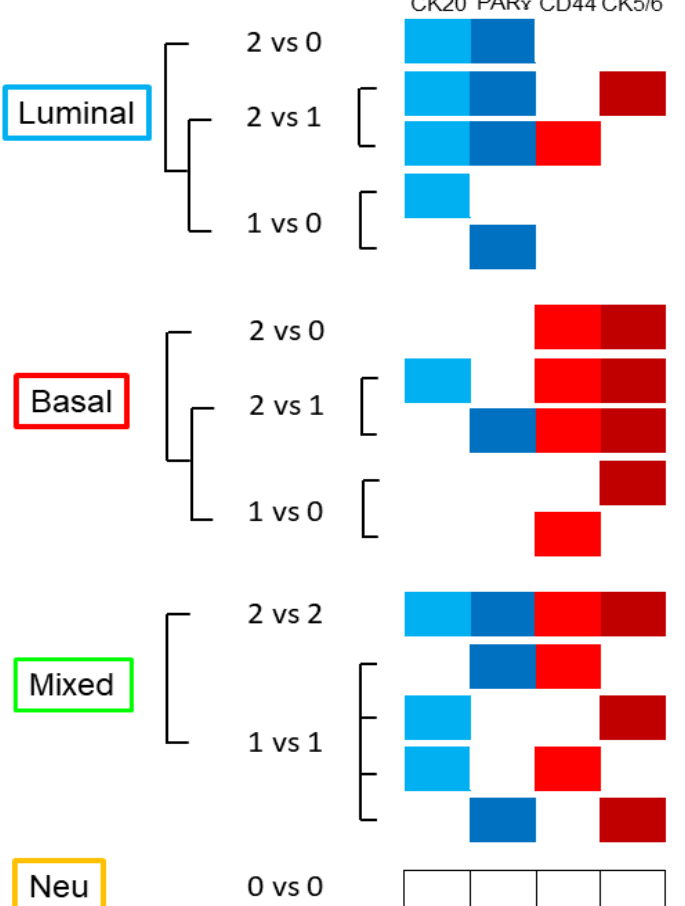
Figure 1. Basal phenotype is defined when at least 3 markers consistent with the basal phenotype are documented; luminal when at least 3 markers consistent with the luminal phenotype are noted; mixed when 1 luminal and 1 basal marker are expressed simultaneously, or 2 luminal and 2 basal markers are expressed simultaneously; and neu-like when 4 markers are negative.